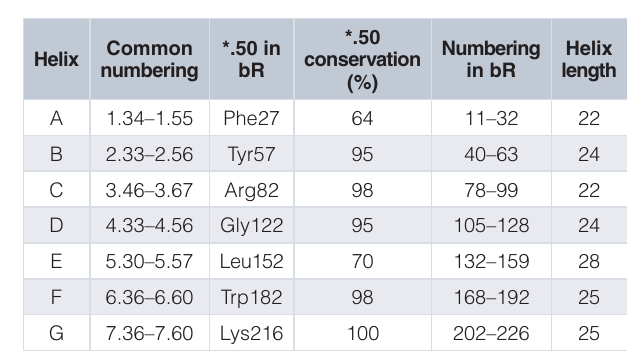
Table 1. The 7TM bundle of 170 residues used for the present study and the proposed common numbering for microbial retinal